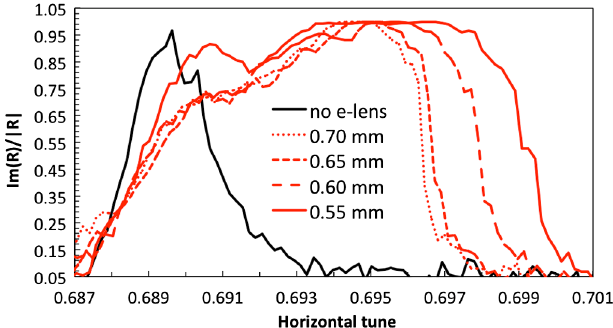
FIG. 22. Incoherent tune distributions for various electron beam sizes and an electron beam current of 900 mA. The beam distributions are measured with beam transfer functions and are aligned to the left with an offset for better visibility of the